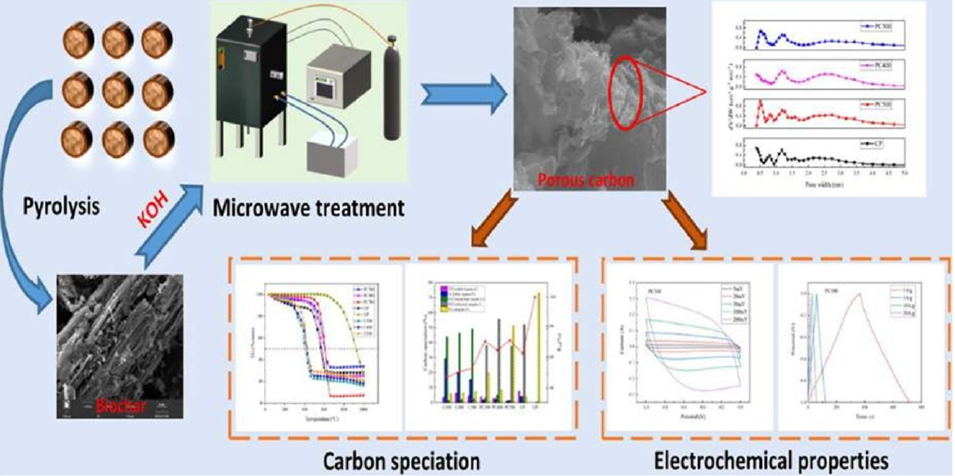
Figure 33. Microwave treatment of chili-straw pyrolysis residue yields high-value porous carbon. Reproduced with permission from [119].